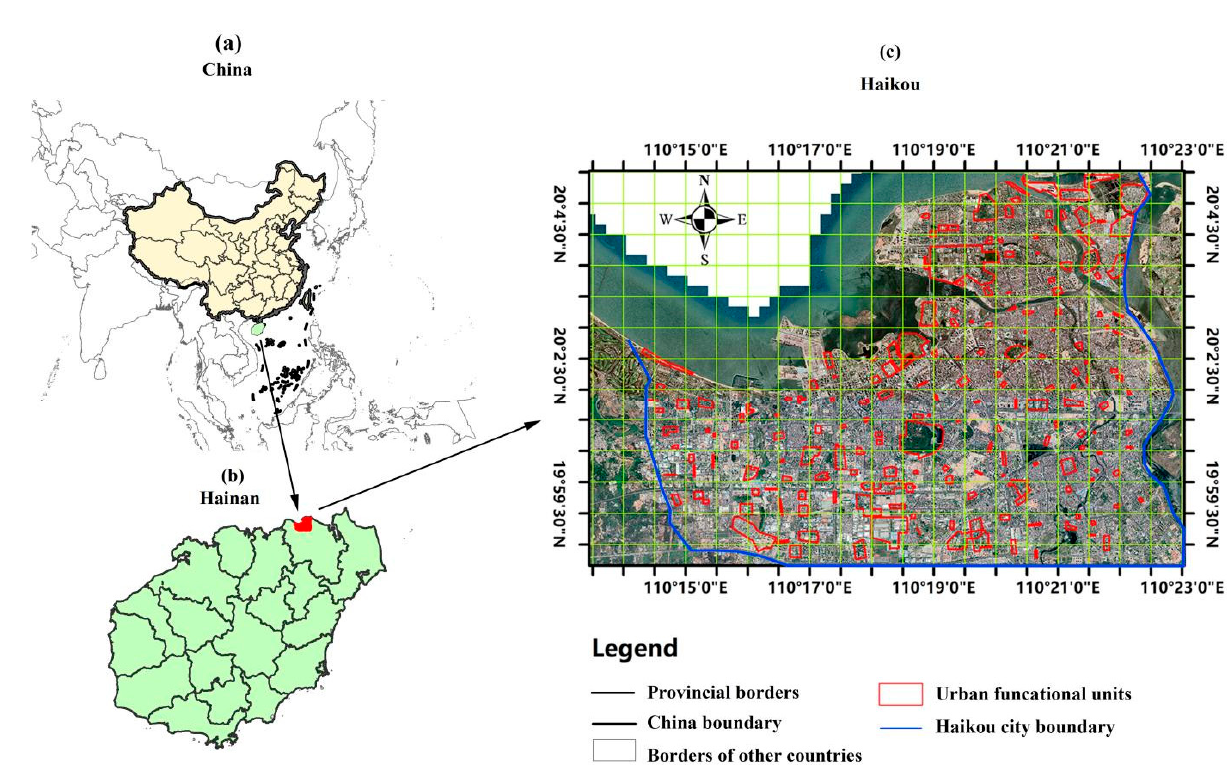
Figure 1. The location of Haikou; ( a ) Map of China highlighting Hainan, ( b ) map of Hainan high- lighting Haikou, and ( c ) satellite imagery of Haikou.